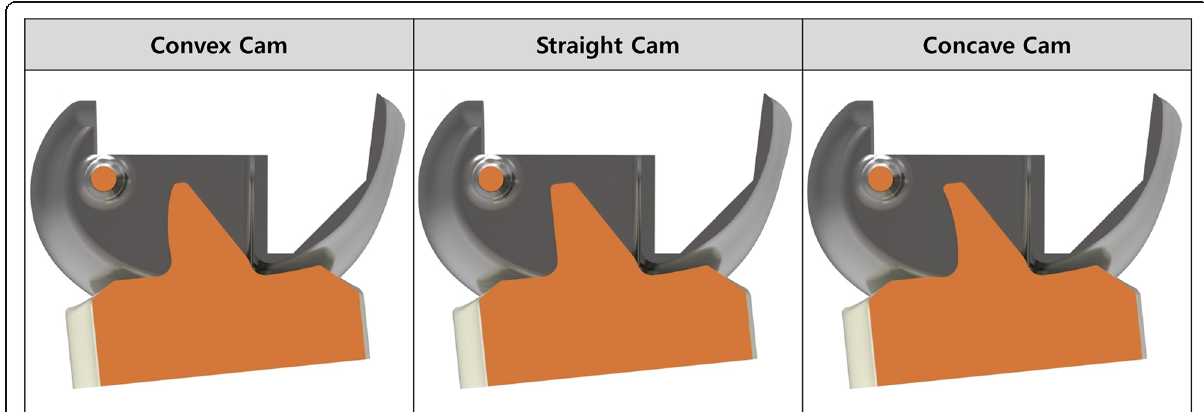
Fig. 2 Three different custom-designed cams in the tibial component